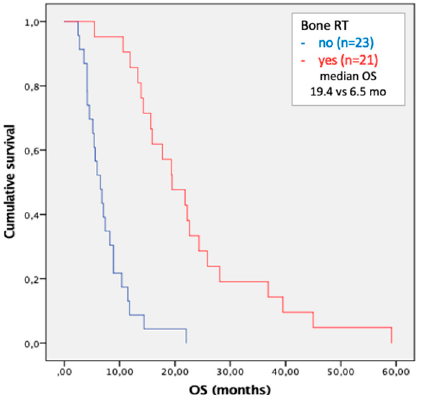
Figure 4. Kaplan–Meier curves of overall survival in patients with bone metastases treated with combination radiation therapy.